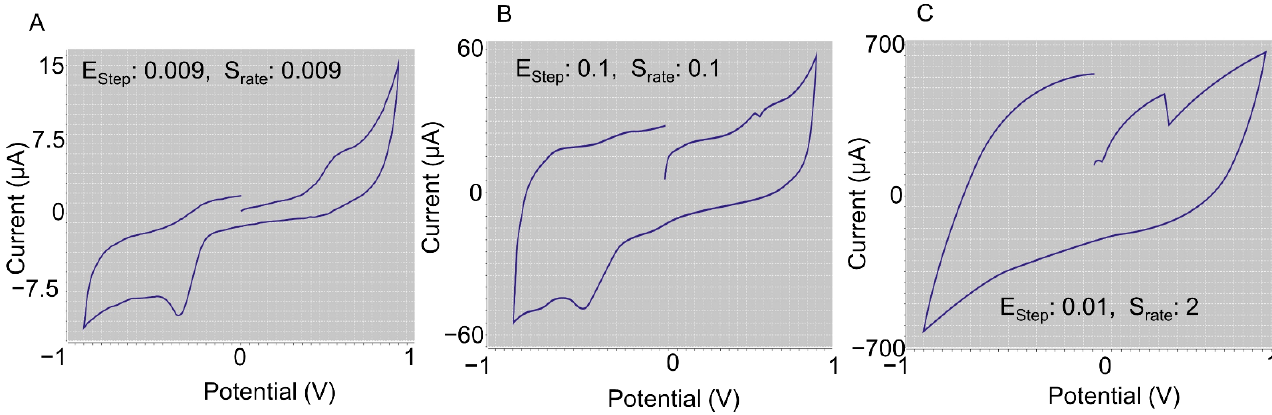
Figure A2. Electrochemical system optimization results for simultaneous varying of S rate and E rate . ( A ) E step = 0.009 and S rate = 0.009; ( B ) E step = 0.1 and S rate = 0.1; ( C ) E step = 0.01 and S rate = 2.